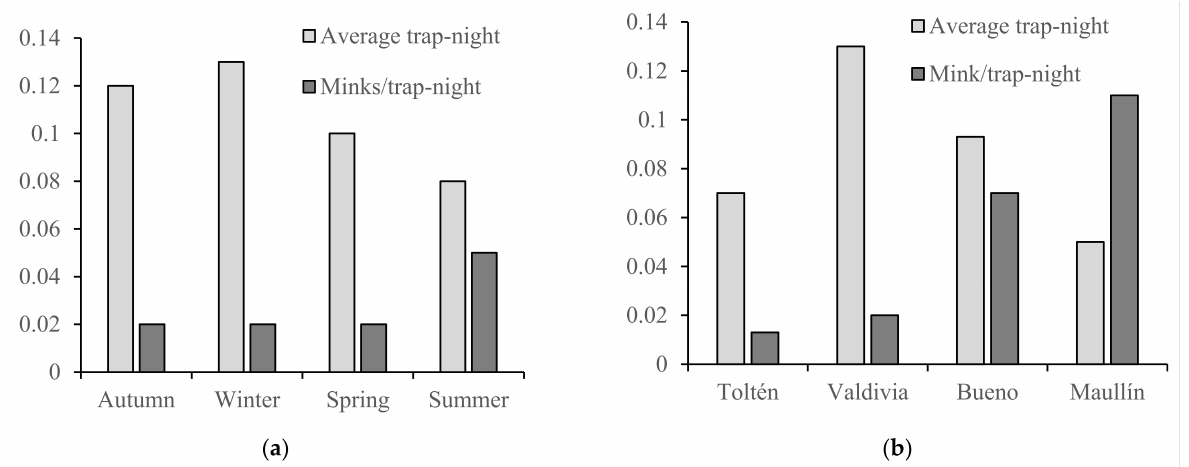
Figure 3. Average trap-nights per transect compared with average mink trapped per trap-night for ( a ) the four seasons and ( b ) the four study river